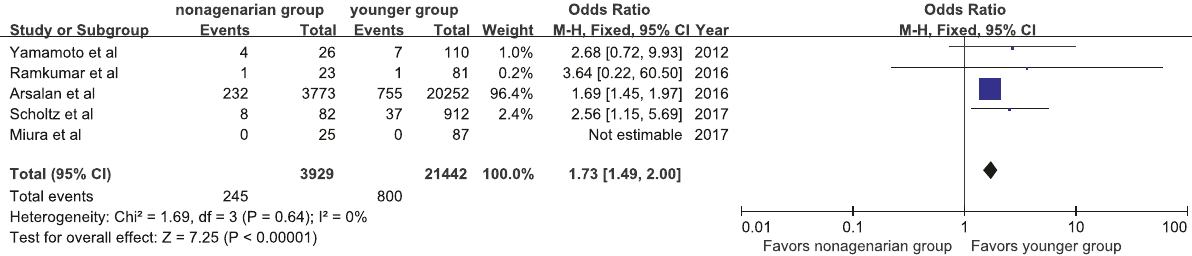
Figure 4: Forest plot of pooled analysis comparing 30-day mortality of nonagenarians versus younger patients.